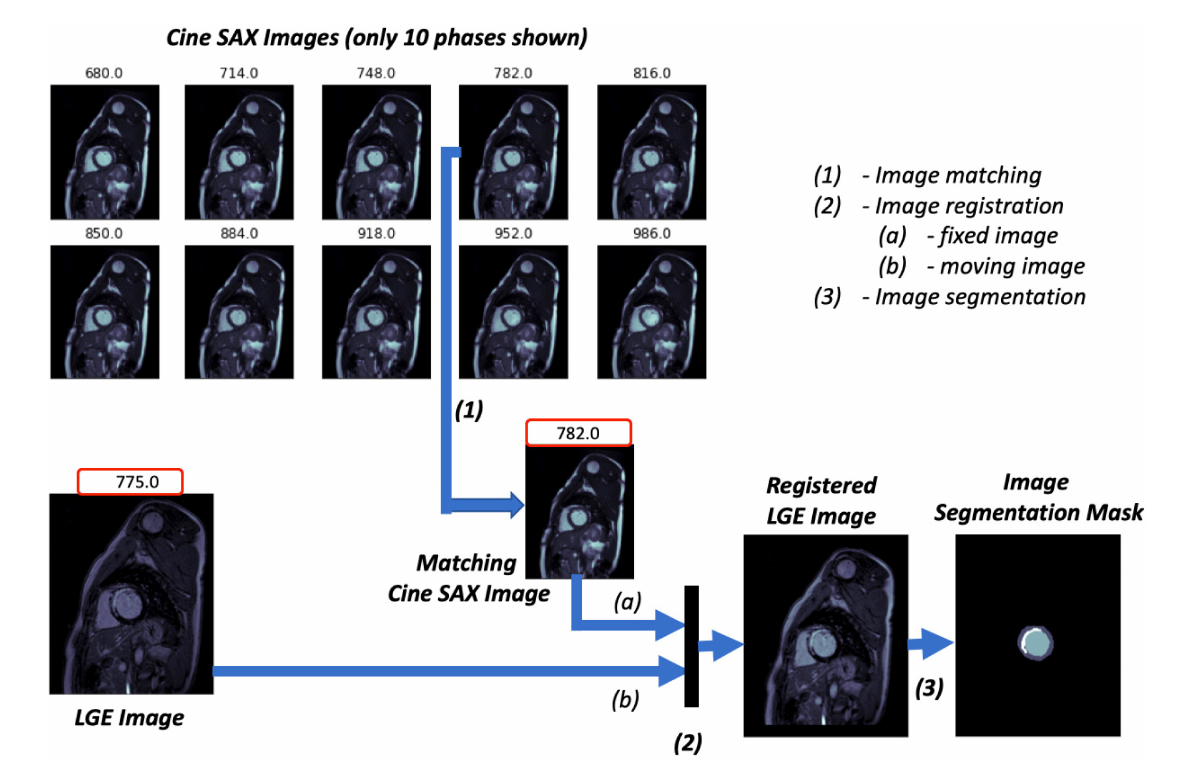
FIGURE2 Image ground truth data pre-processing pipeline. The trigger times (TT) in ms for the 10 cine short axis (SAX) images shown are given at the top of each image. The cine SAX frame with closest TT match to the late gadolinium enhancement (LGE) image’s TT is selected (1); this is followed by an image registration process (2), where the “fixed” image and the “moving” image of the registration process are denoted (a) and (b), respectively. The regions of the epicardium, the endocardium, and the scar are segmented in